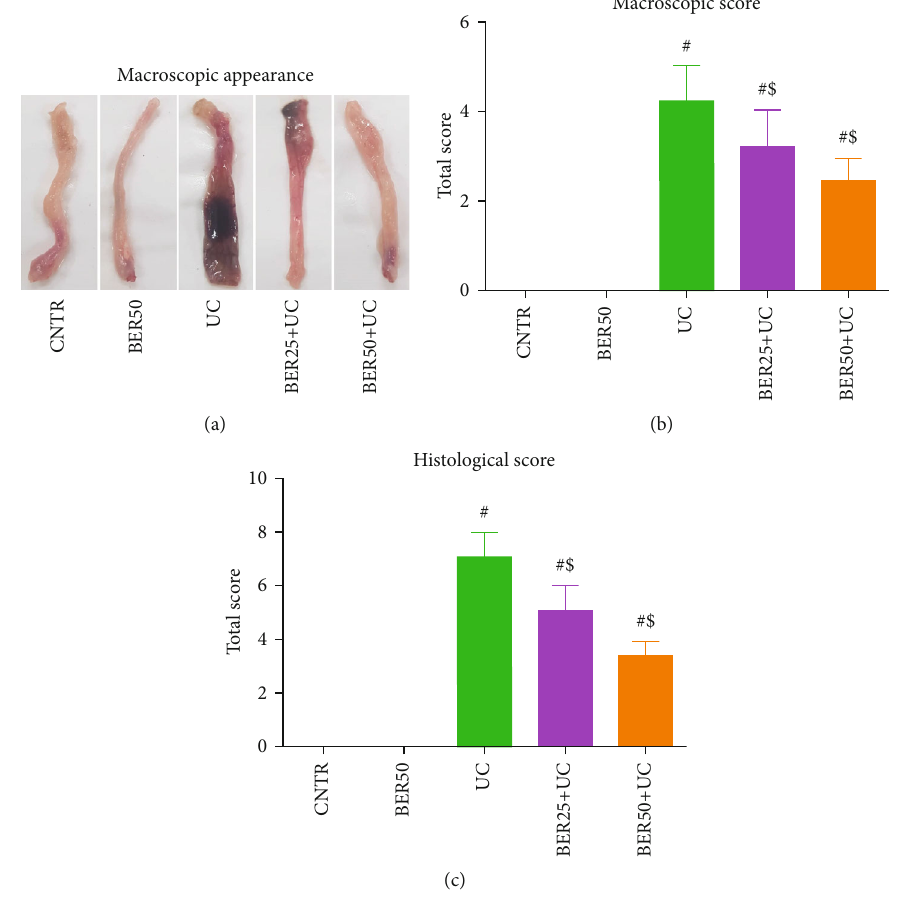
Figure 1: E ff ect of berberine at di ff erent doses on experimental colitis in rats. (a) Macroscopic appearance of rat colon in experimental colitis. (b) Macroscopic score. (c) Histological score. The results are expressed as the mean ± SD ( n = 7 ). # p < 0 : 05 compared to the CNTR group (intact group); $ p < 0 : 05 compared to UC-untreated